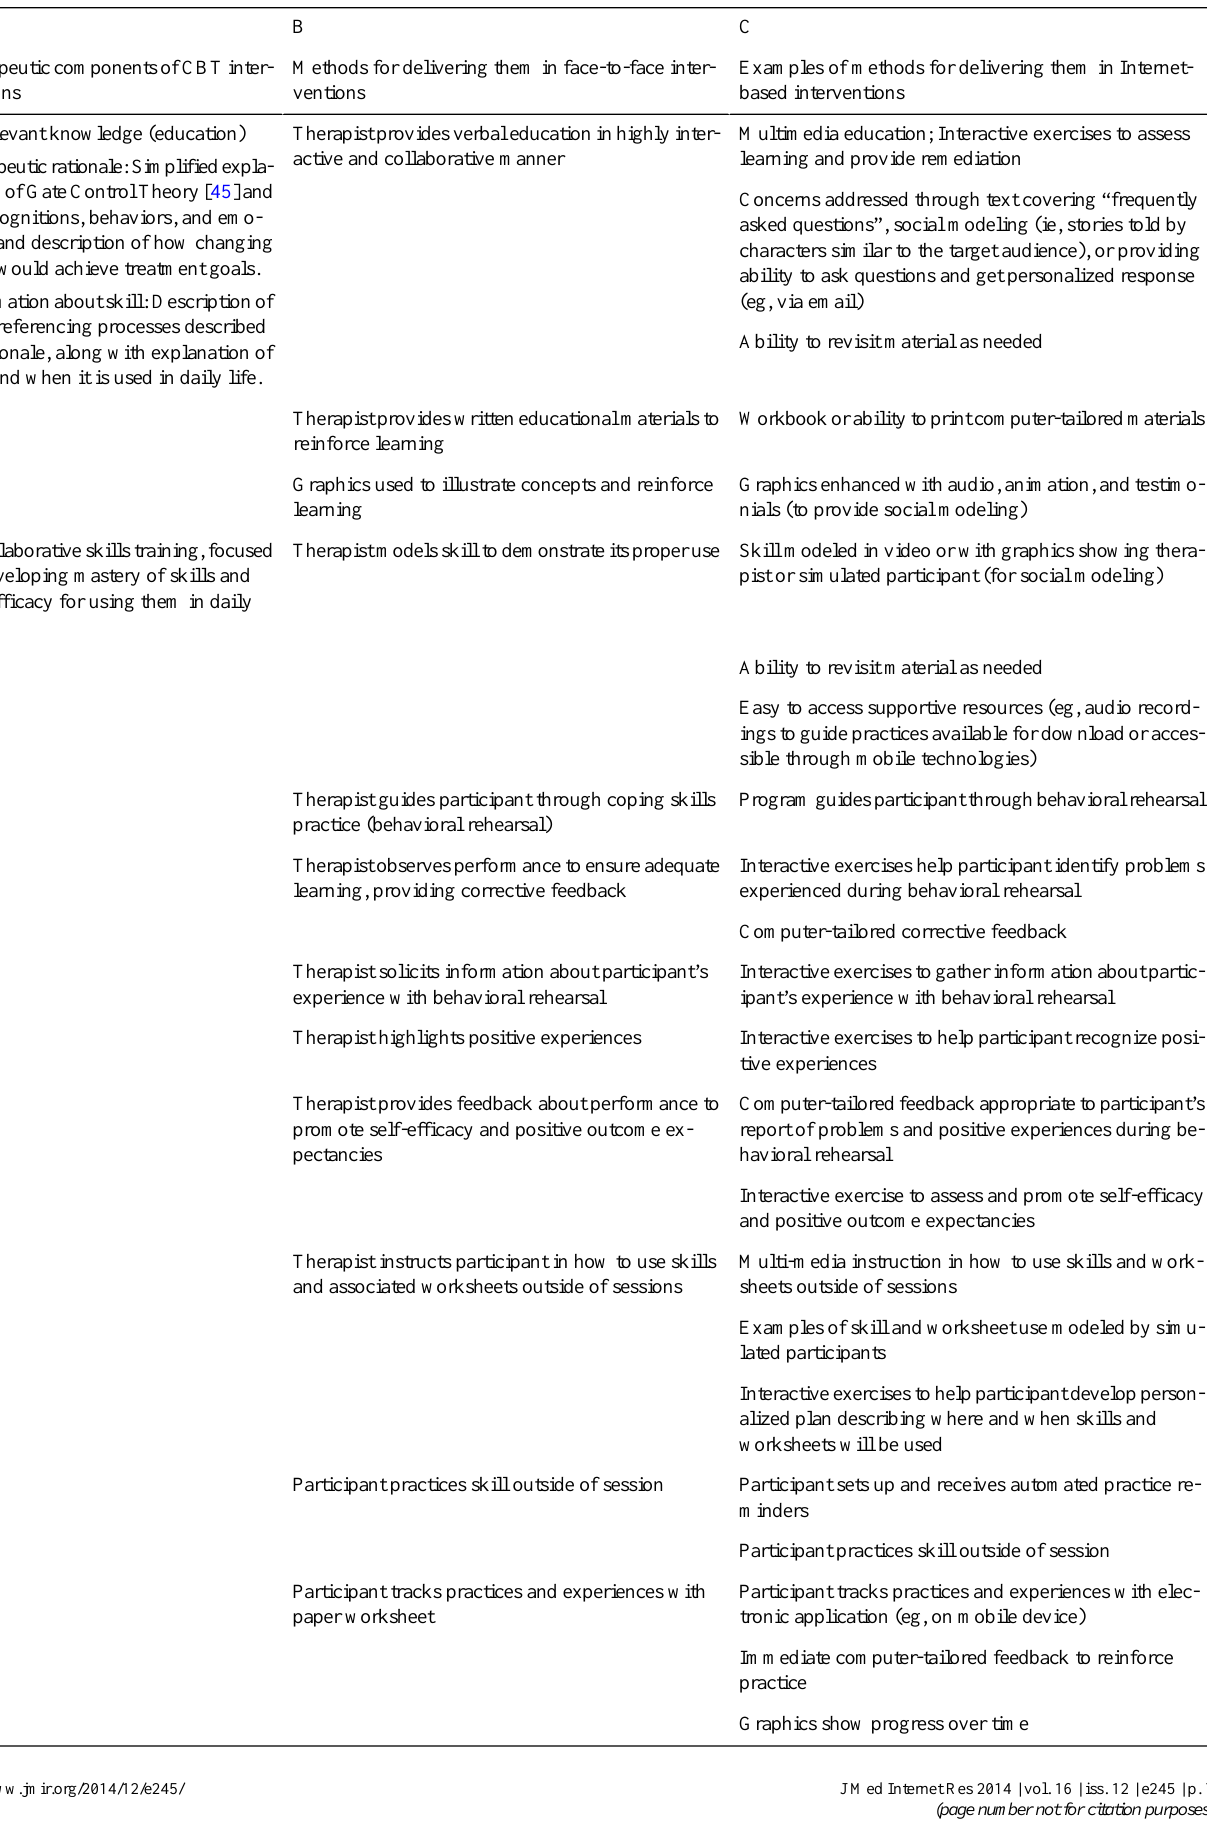
Table 1. Therapeutic components and processes of cognitive behavioral